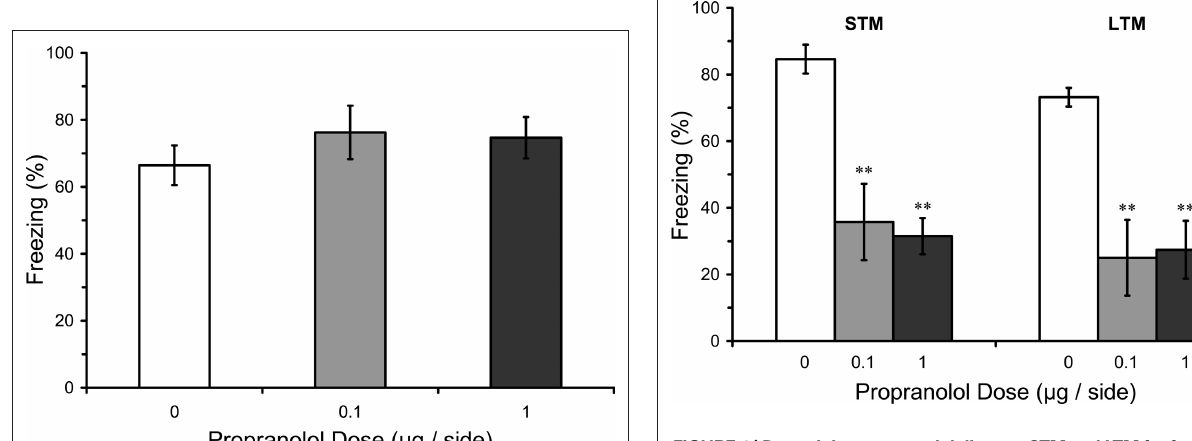
Figure 4 | Pre-training propranolol disrupts STM and LTM for fear conditioning. Rats from Experiment 2 were given microinfusions of propranolol (0 μg, n = 7; 0.1 μg, n = 6; 1 μg, n = 6) into the lateral amygdala (LA) prior to three-trial auditory fear conditioning. Propranolol pre-treated rats showed attenuated short-term memory (STM) when tested at three hours after fear conditioning, and memory was still impaired when tested for long-term memory (LTM) 2 days later. The figure depicts mean freezing levels during the STM and LTM tests. ** indicates significantly lower freezing relative to vehicle ( p <